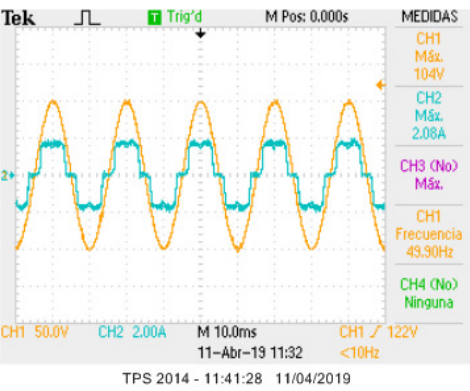
Figure 13. Experimental results: output voltage and inductor current for phase a with a resistive load change.